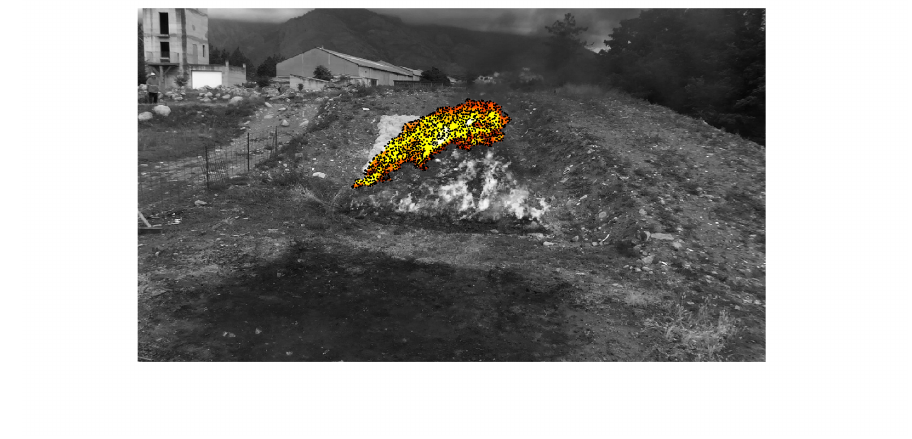
Figure 29. Detected frontal fire area and matched